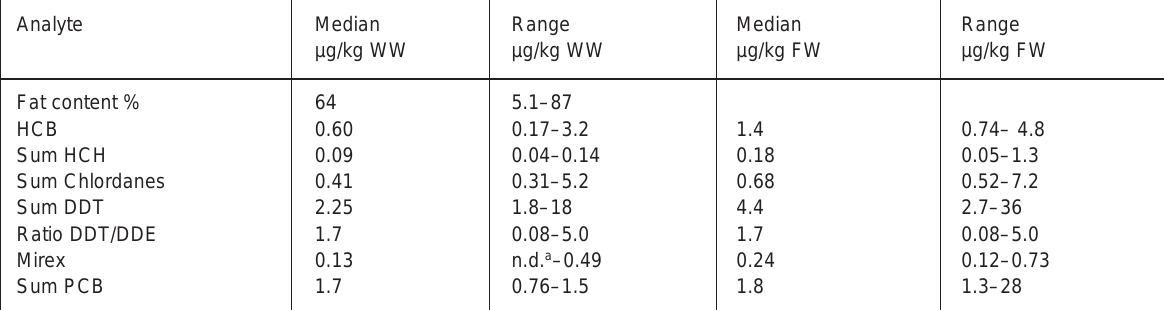
TABLE 1 Concentrations of pesticide residues in fat (µg/kg wet weight (WW) and µg/kg fat weight (FW) from 14 male hippopotami collected at Mfuwe in the southern Luangwa National Park, Zambia during October 1998